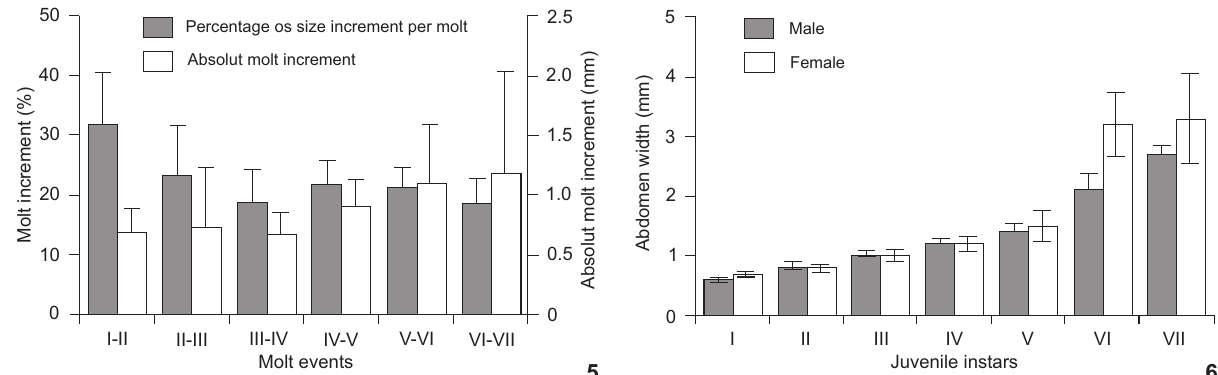
Figures 5-6. Pachygrapsus gracilis : (5) mean percentage of molt increment and mean absolute molt increment for each juvenile instar; (6) mean abdomen width of males and females in each juvenile